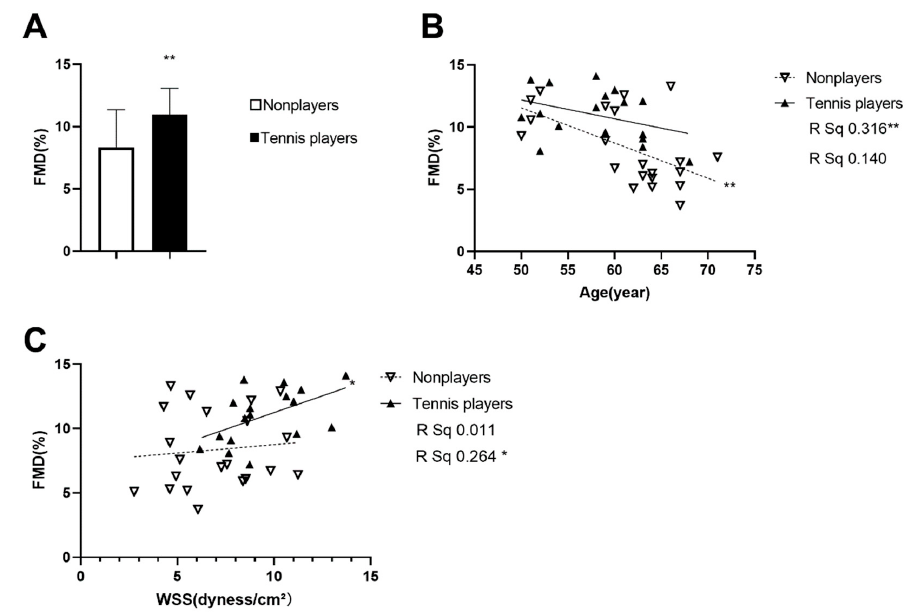
Figure 1. * p < 0.05 and ** p < 0.01 were considered statistically significant. Comparison of the Figure 1. ** P < 0.01 was considered statistically significant. Comparison of the flow-mediated dila- flow-mediated dilation (FMD) between the tennis players and nonplayers ( A ); correlation of the tion (FMD) between the tennis players and nonplayers (A); correlation of the FMD with increasing FMD with increasing age between the tennis players and nonplayers ( B ); correlation of the FMD with age between the tennis players and nonplayers (B); correlation of the FMD with increasing vessel increasing vessel wall shear stress (WSS) between the tennis players and nonplayers ( C wall shear stress (WSS) between the tennis players and nonplayers (C).